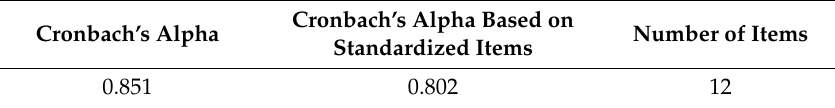
Table 1. Cronbach’s